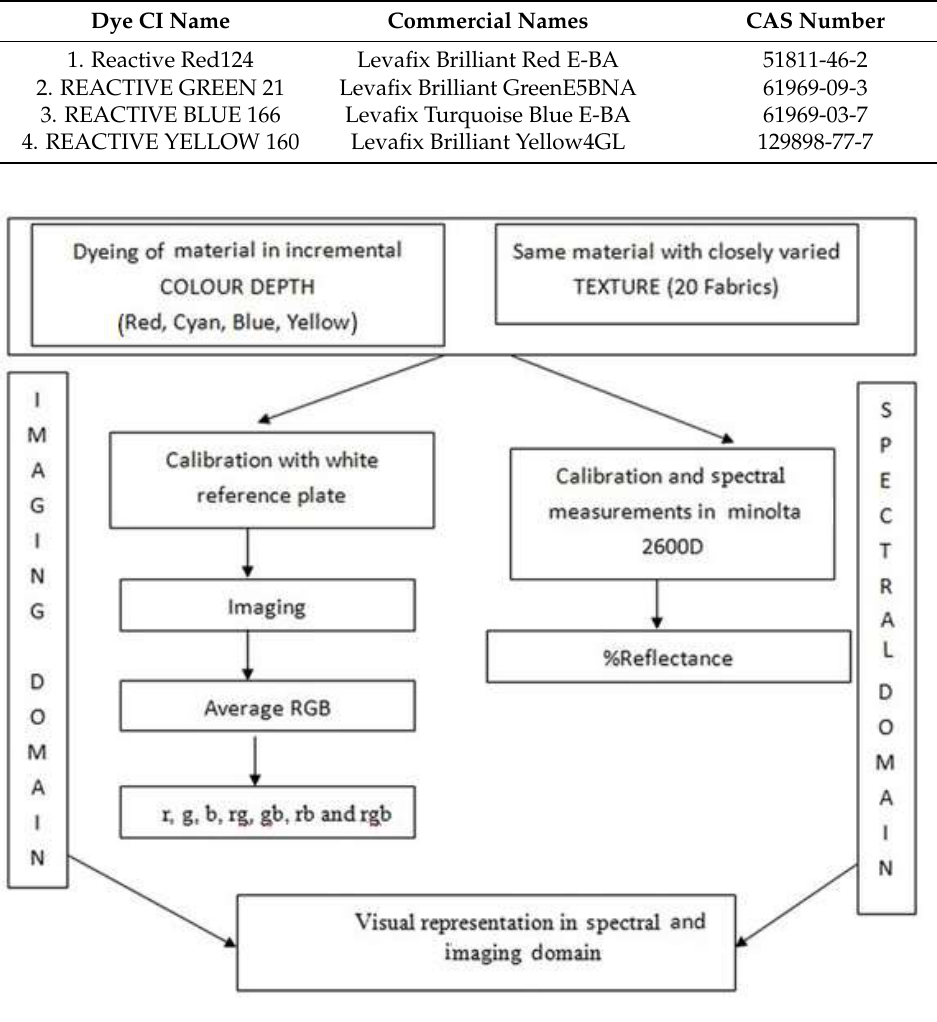
Figure 3. Figure 3. Workflow.